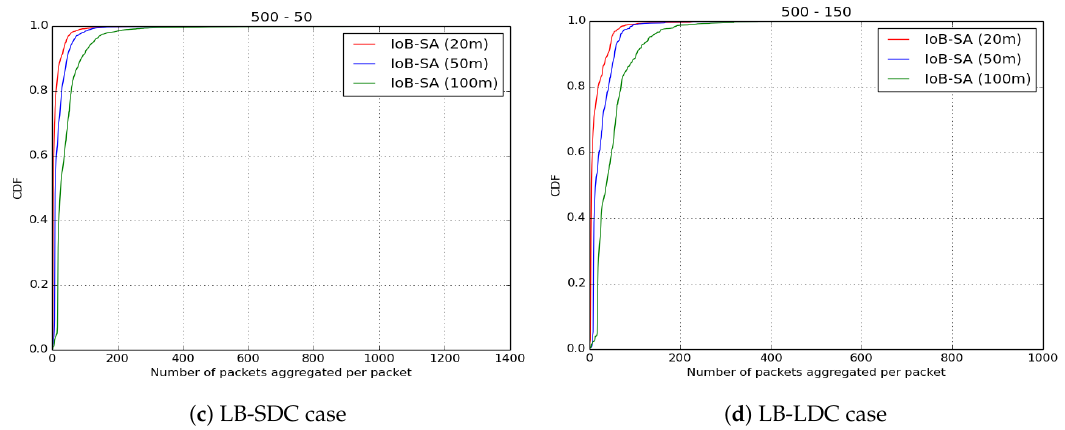
Figure 28. Average number of aggregated packets per packet for IoB-SA.